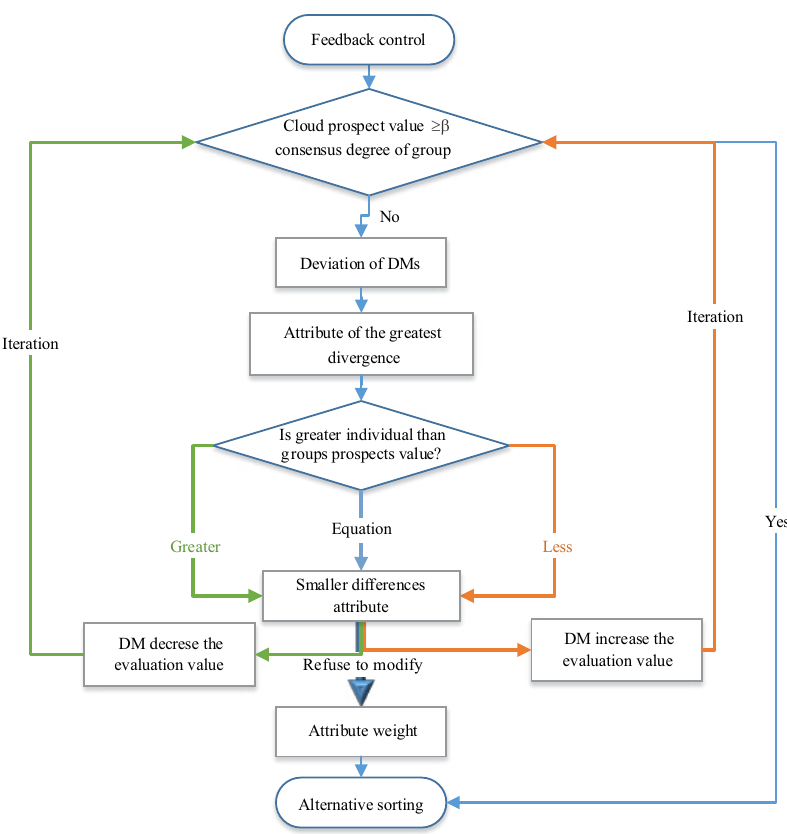
Fig. 2. Feedback control diagram of